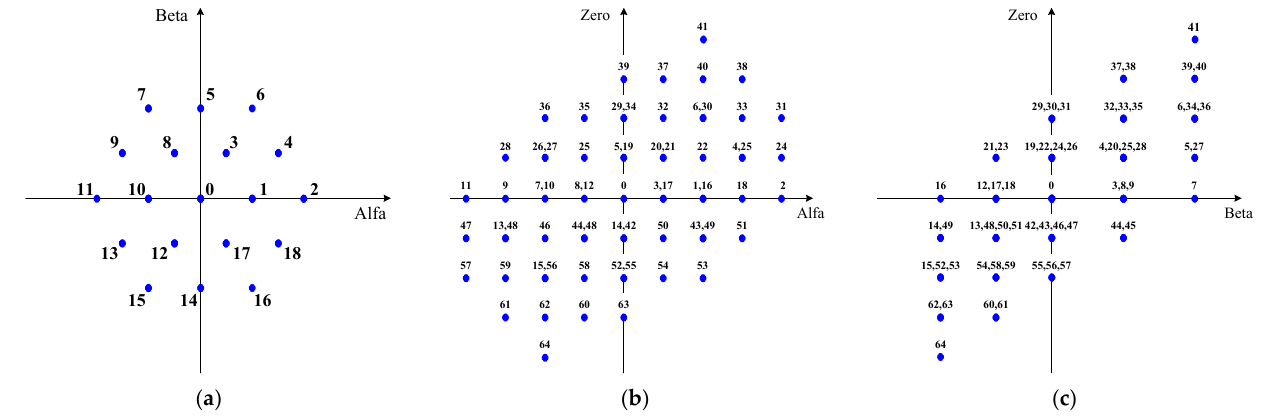
Figure 4. Voltage vectors that can be applied at the output of the proposed converter in the two-dimensional space: ( a ) αβ plane; ( b ) α o plane; ( c ) β o plane.